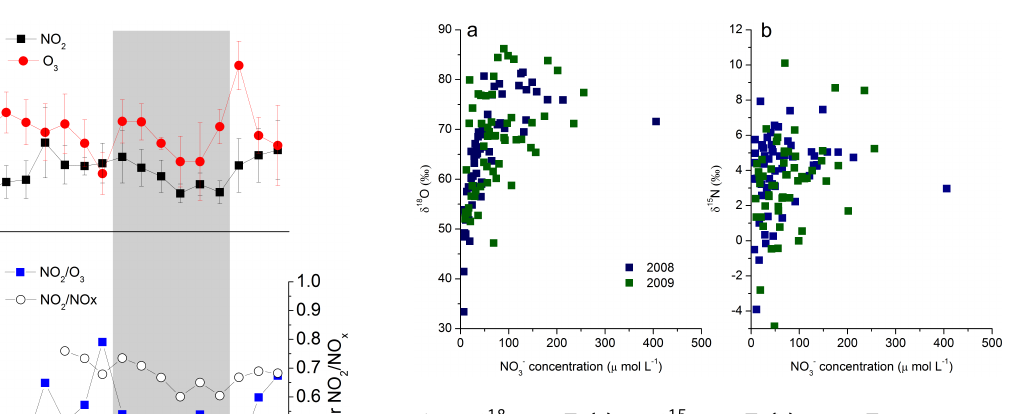
Fig. 6. δ 18 O-NO − (a) and δ 15 N-NO − (b) vs. NO − concentration 3 3 3 in precipitation over the study period. For panel (a) , R 2 = 0 . 21, P < 0 . 001 in 2008; and R 2 = 0 . 20, P = 0 . 001 in 2009. For panel (b) , R 2 = − 0 . 03, P = 0 . 22 in 2008; and R 2 = 0 . 24, P < 0 . 001 in